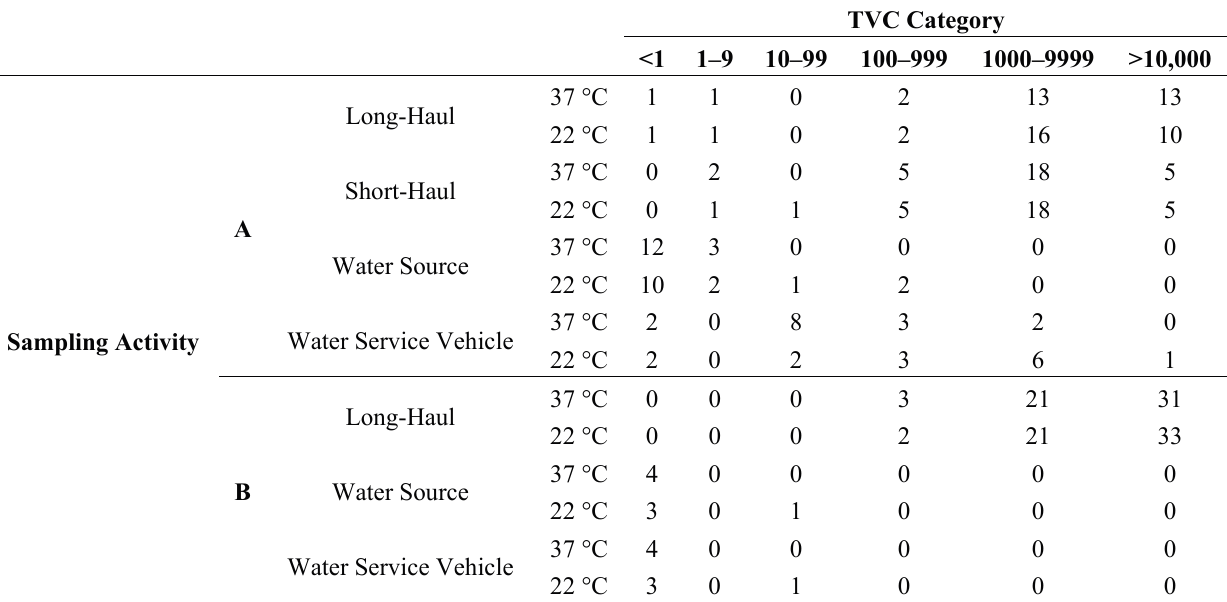
Table 9. The distribution of TVC results by contamination